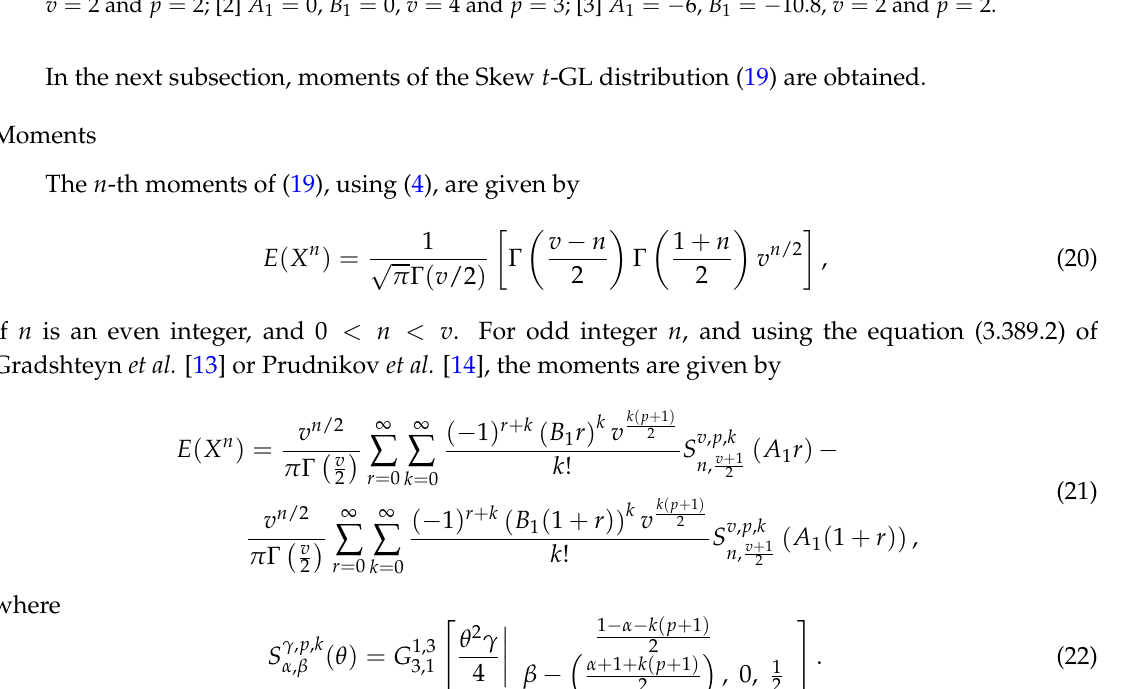
Figure 3. The Skew t -GL distribution using the following parameter values: [1] A 1 = 6, B 1 = 10.8, v = 2 and p = 2; [2] A 1 = 0, B 1 = 0, v = 4 and p = 3; [3] A 1 = − 6, B 1 = − 10.8, v = 2 and p =